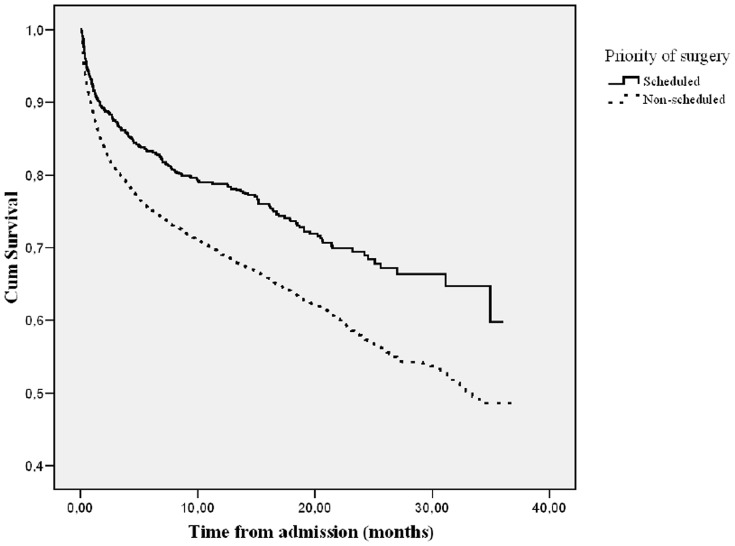
Survival Function for ‘Priority of Surgery’.